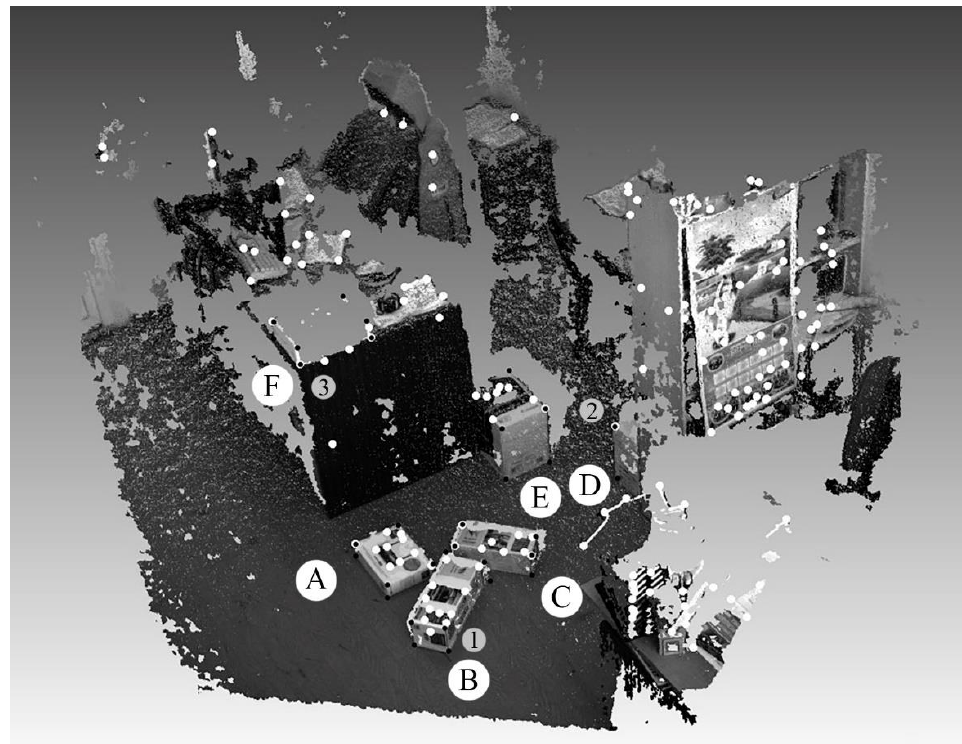
Figure 9. The figure shows the points identified in the 3D cloud (marked in black) as belonging to the sought objects. Their number was 13: on object A—2, on B—3, on C—3, on D—1, on E—1, on F—3. The matrix connecting the CS of objects with the CS of the camera was calculated by 3 points (they are marked with numbers 1, 2, 3), which were selected by the algorithm from the found points.